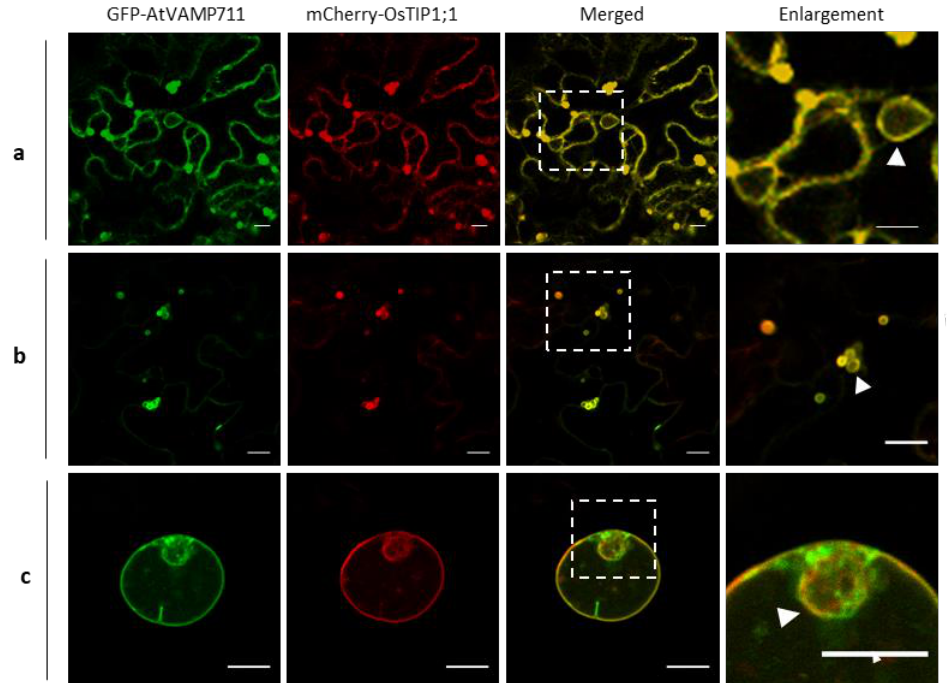
Figure 1. Co-localization of OsTIP1;1 (tonoplast intrinsic proteins 1;1 in rice) and AtVAMP711 (vesicle-associated membrane protein 711 in Arabidopsis ) in transient expression systems. ( a and b ) Transient expression in epidermal tobacco leaves. OsTIP1;1 co-localized with tonoplast protein AtVAMP711 at central (lytic) vacuoles ( a ) and small bubble-like vacuoles ( b ), respectively. The laser intensity of the GFP (green fluorescent protein) channel was 10% in ( a ) and 5% in ( b ), and other settings including the emission, smart gain, and offset were the same. ( c ) Co-localization between OsTIP1;1 and AtVAMP711 in rice protoplast. The dashed white squares indicate regions of enlargement (right panel). The arrow heads indicate presumed vacuoles. Scale bars: 10 µm.